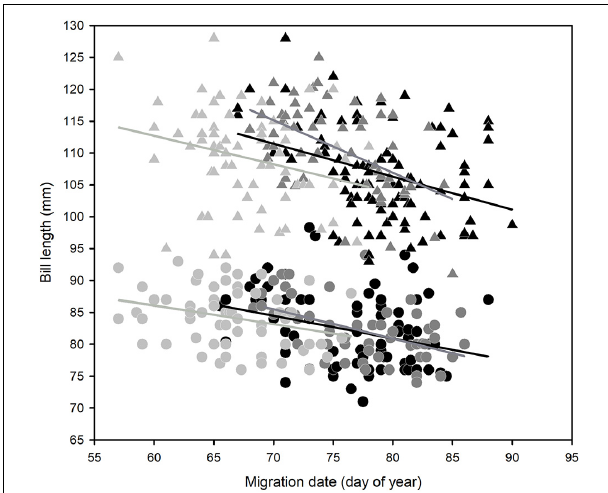
FIGURE 4 | Relationships between body size (represented by bill length) and migration date in bar-tailed godwits in New Zealand. The sexes are shown with different symbols: males (smaller) are the circles, while females (larger) are the triangles. The symbol shading represents the three study sites: black = Auckland, dark gray = Manawatu, and light gray = Otago. Trends are shown by the fitted lines (from a linear regression of size nested within sex within site).